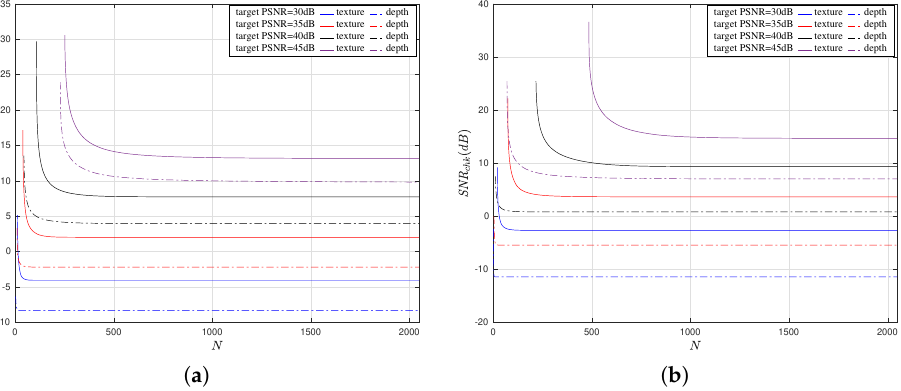
Figure 8. Power and bandwidth usage trade-off curves for different video sequences: ( a ) Kendo; ( b )